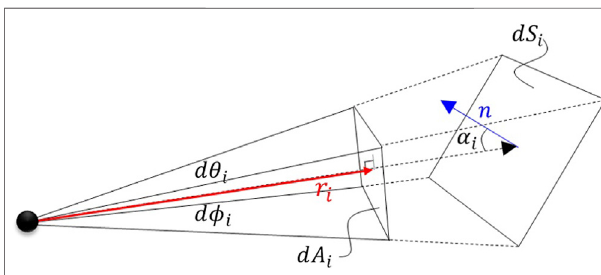
FIGURE 3 | Projected ray surface area and surface area patch of the visual